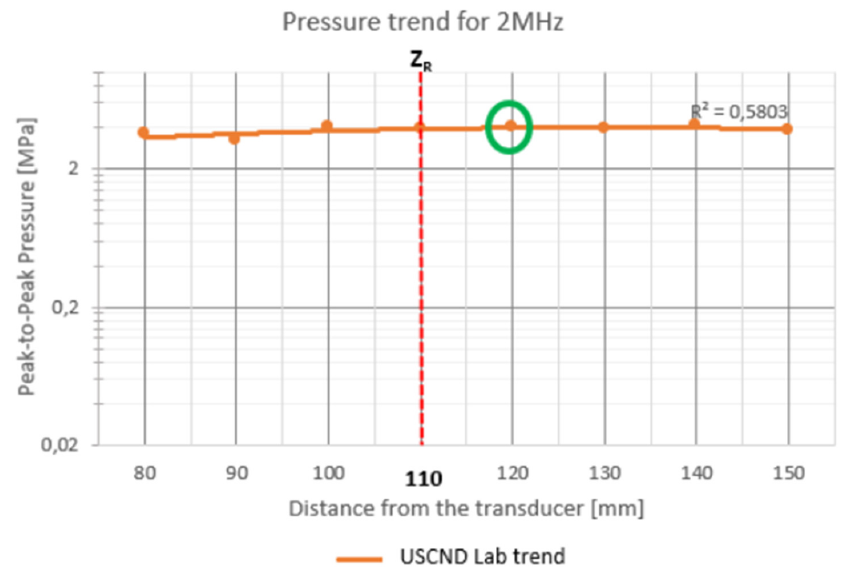
Figure 4. Focal distance calculation. At 1 MHz stimulation frequency the selected stimulation point is at a distance of 90 mm from the transducer (green circumference), this point in fact results in the Far Field. This value results from a test made with the hydrophone and by a subsequent linear interpolation. Z R indicates the distance of Rayleigh (dotted line in red). The orange line in the figure indicates the peak-to-peak pressure trend carried out by the Ultrasound and Non Destructive Testing (USCND) laboratory of the Dept. of Information Engineering of the University of Florence.